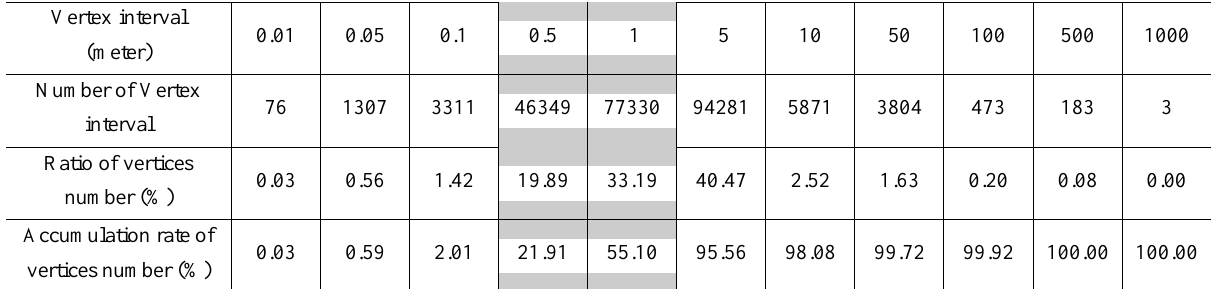
Table 2. The number of vertex according to different vertex interval